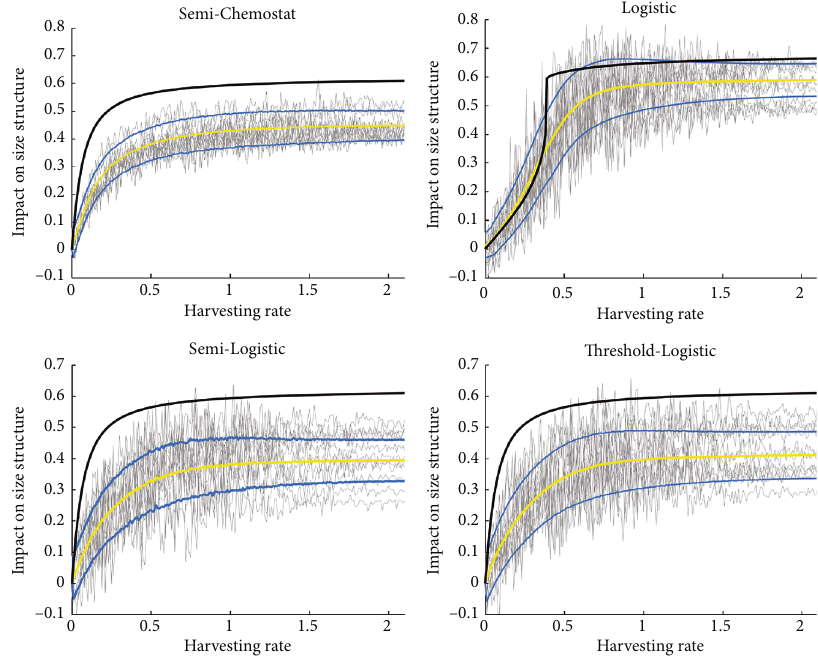
Figure 13: Impact on size structure of semichemostat, logistic, semilogistic, and threshold-logistic growth rate at steady state w.r.t. harvesting rate. The grey trajectories show the impact on size structure from di ff erent simulations for the stochastic case. The yellow curve represents the mean value of the simulations. The light blue curves represent the interval of standard deviation (68%). The black curve represents the impact on size structure for the deterministic case. Equation (17) is used to derive the above graphs.